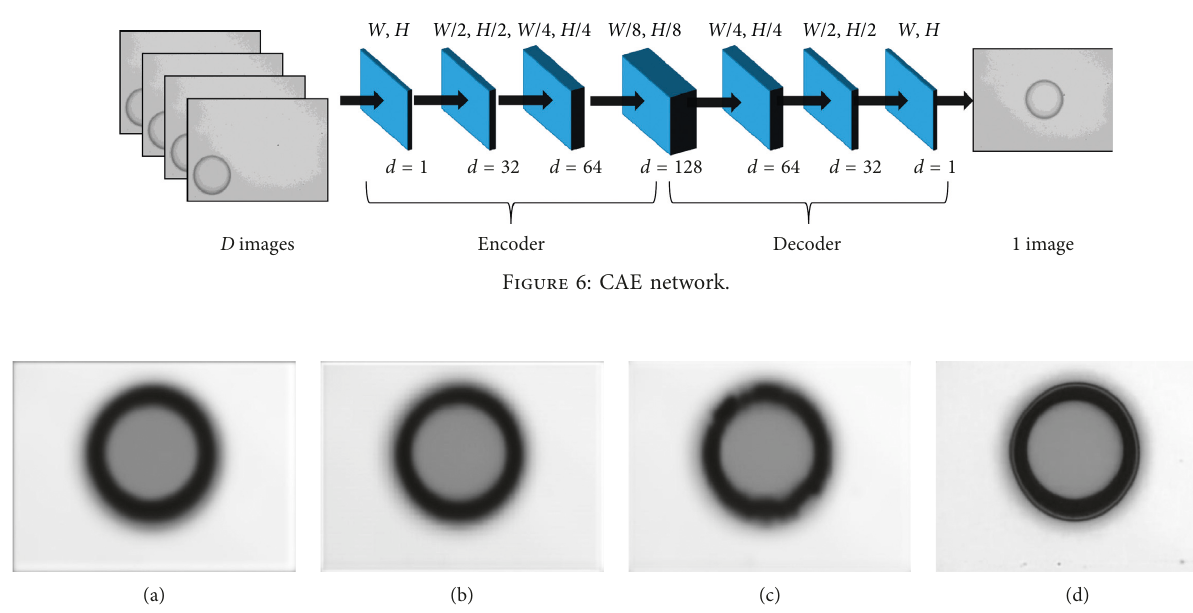
Figure 7: Change in normal PS according to training epoch. (a) 1 epoch. (b) 25 epochs. (c) 50 epochs. (d) 100 epochs.